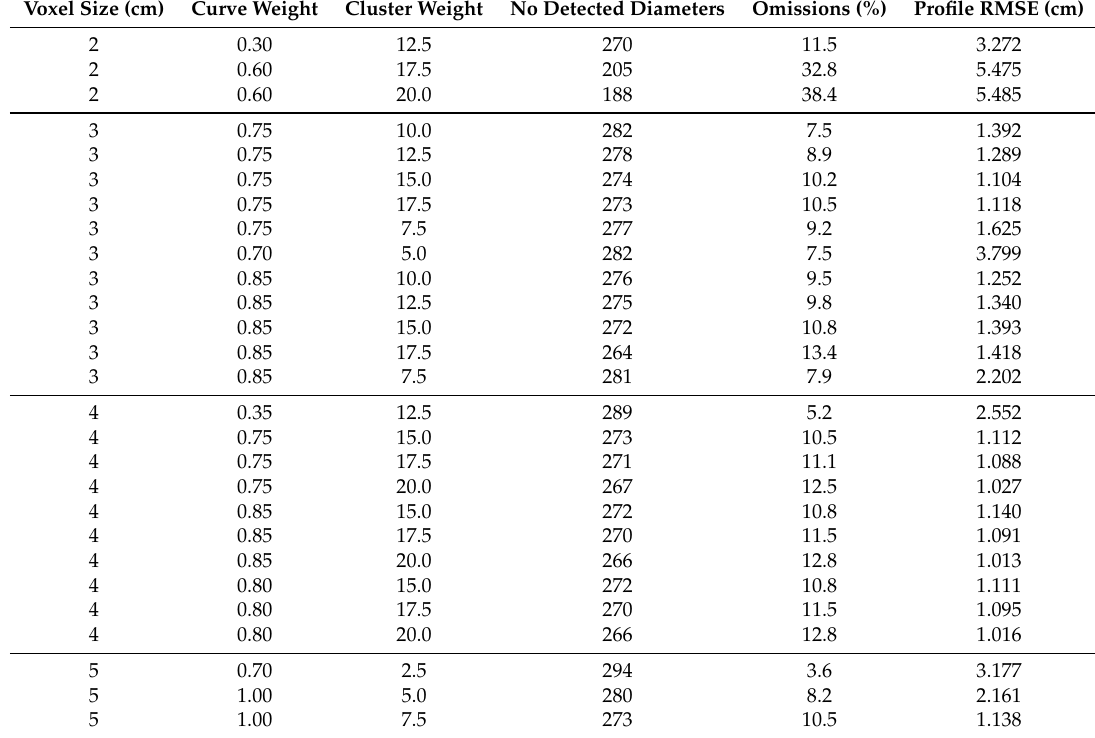
Table 6. Stem profile diameter RMSE and omission errors of the trees in Plots 1–6 at the Svartberget test site for the chosen parameter settings in Tables 4 and 5. The total number of manually-calipered stem profile diameters is 305.